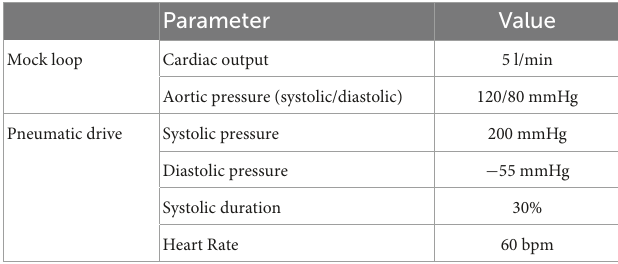
reservoir was used to mimic atrial preload, and a 23 mm pyrolytic carbon bileaflet valve was used to replace the mitral valve.